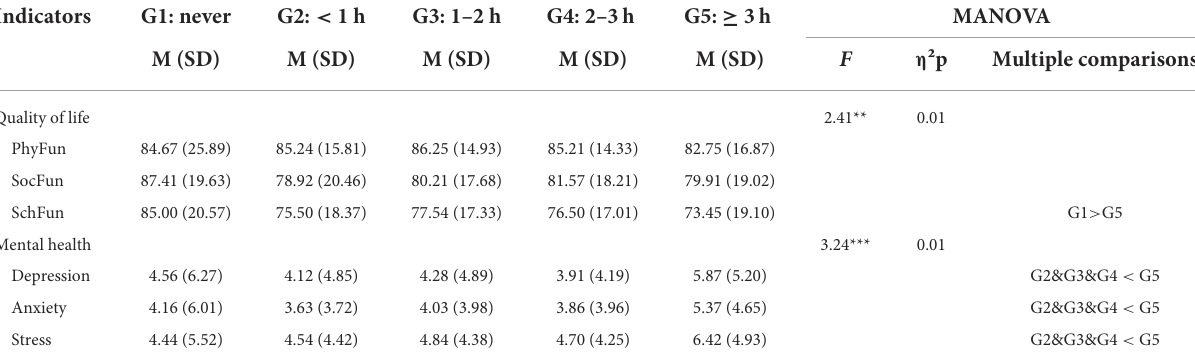
TABLE 3 Results of MANOVA comparing the mental health and quality of life of the participants in conjunction with their daily amount of SNSs.